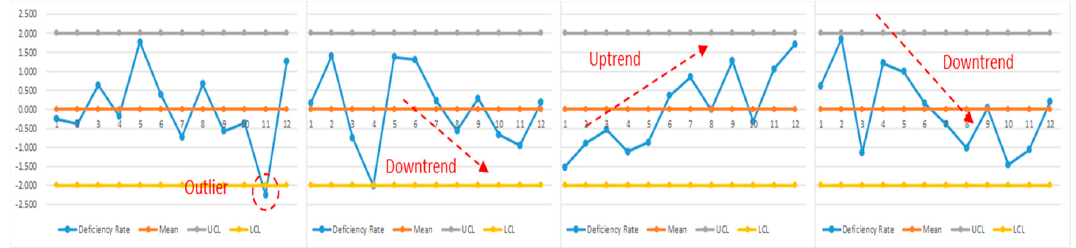
Figure 8. The control chart for deficiency 01 (2015–2018).